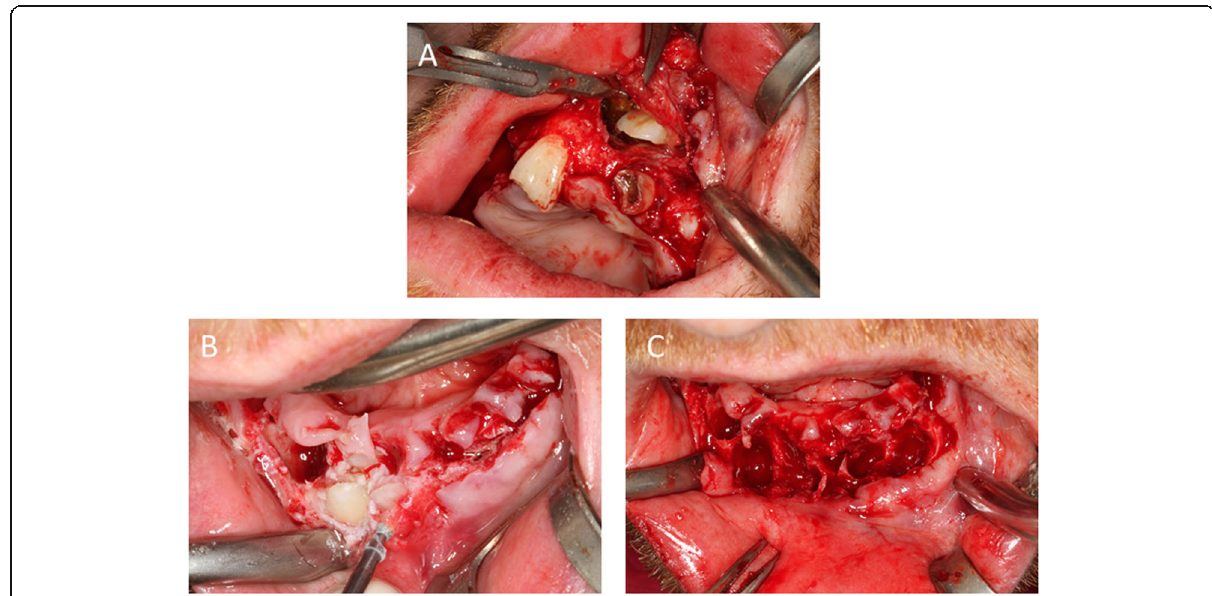
Fig. 3 a Removal of tooth 13 with the retention cyst. b Exposure of the impacted teeth. c Defect in the mandible after tooth